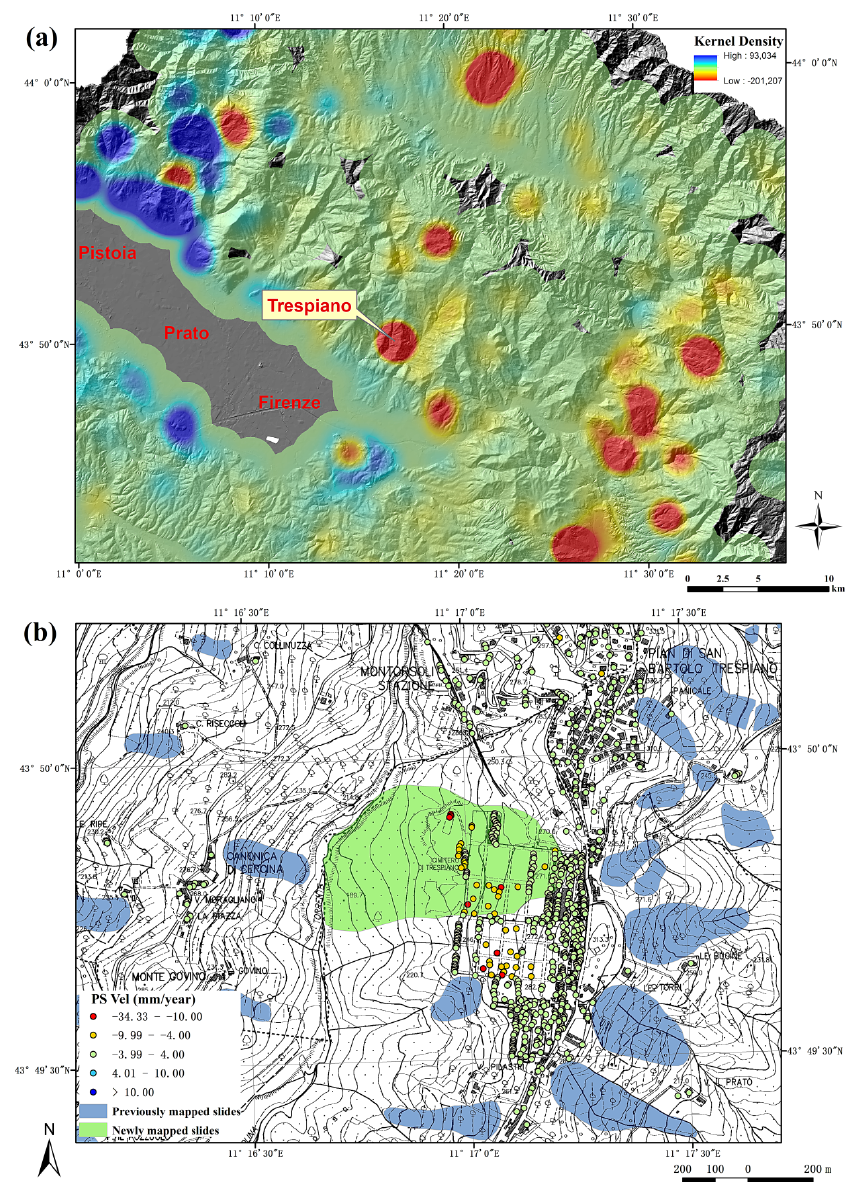
Figure 7. The detection of an active slide in Trespiano through PSI Hotspot and Clustering Analysis (PSI-HCA). ( a ) The landslide hotspot map covering Pistoia-Prato-Firenze basin and the Trespiano area: blue and red hotspots indicate mass movements moving towards and away from LOS, respectively. ( b ) The previously mapped slides and a newly detected active slide in